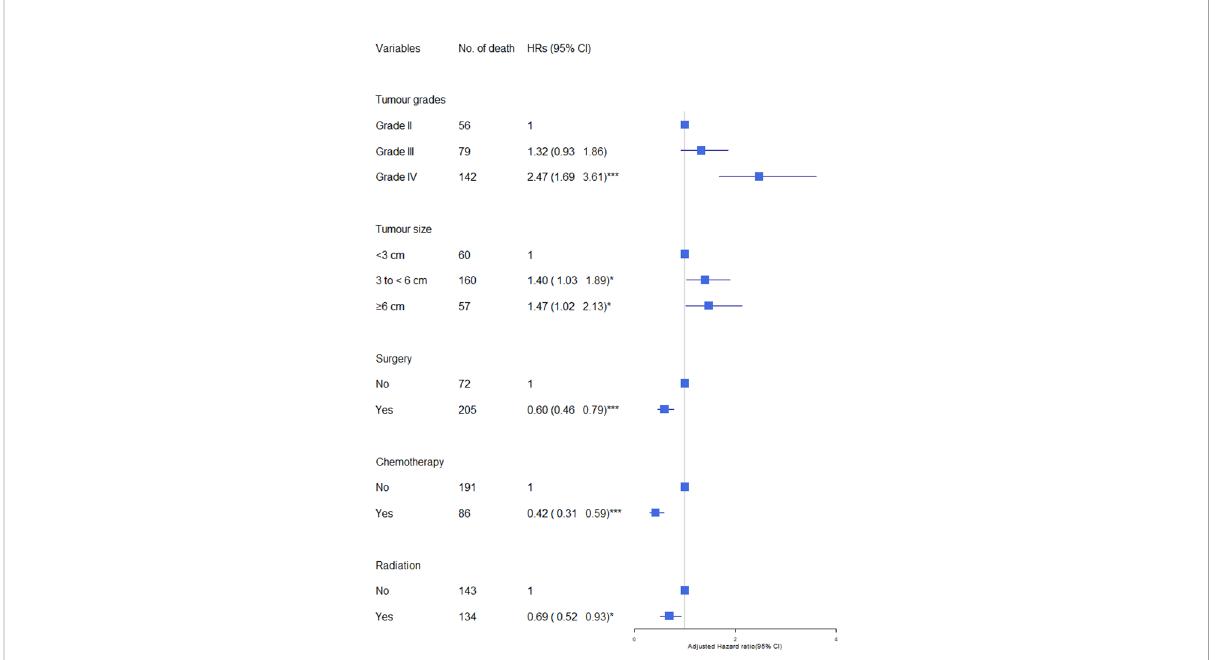
FIGURE 1 Association of tumour characteristics and cancer treatment with cerebrovascular mortality in glioma patients. The hazard ratios (HRs) were calculated using cox regression model and adjusted for variable shown, age, sex, race/ethnicity, marital status and calendar years. CI, Con fi dence intervals. Signi fi cance code: *** p<0.001, *